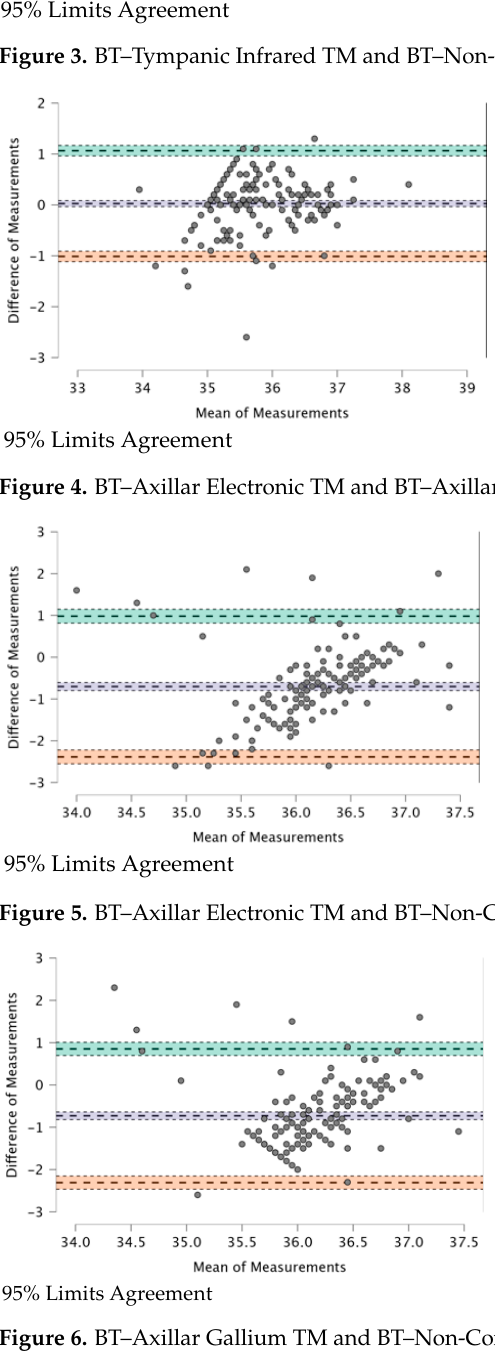
Figure 6. BT–Axillar Gallium TM and BT–Non-Contact Infrared TM (Forehead). Figures 1 to 6 show the measurements of two TMs against the difference of the meas- urements, with a limit of agreement of 95%. The points are grouped around a “zero” line and the degree of dispersion, which is determined by the amplitude of the differences in the results between the TMs. The greater the degree of dispersion, the worse the agreement between the two TMs. The lines that coincide with a standard deviation below and above the zero mean were included, which represent the limits that we deemed acceptable between the two methods to con- sider good agreement. The Non-Contact Tympanic Infrared TM and Non-Contact Infra- red TM (Forehead) (see Figure 3) and Axillary Electronic TM and Axillary Gallium TM